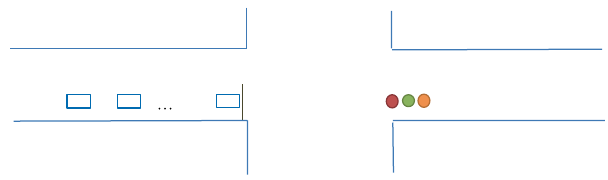
Figure 3: A platoon of eleven vehicles proceed as the traffic light turns from red to